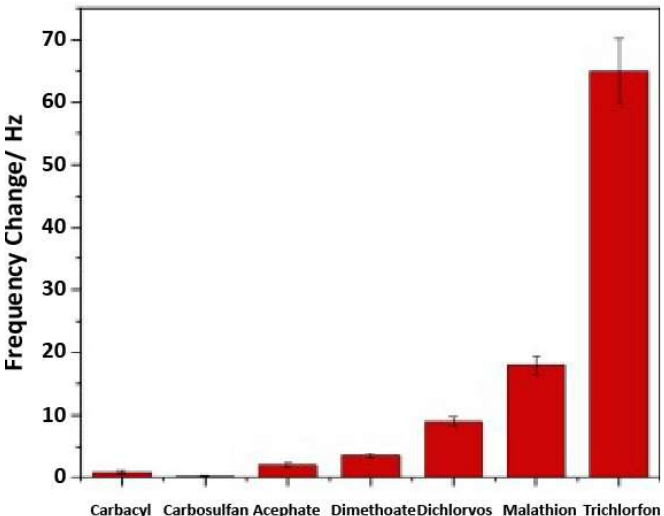
Figure 15. Selectivity of trichlorfon imprinted polymer at 100 ppb with various analogous com- pounds. MIPs were produced by combining 12 mg of polyvinylidene fluoride with 4 mg of template trichlorfon in 8 mL of dimethylformamide and drop-casting onto a quartz crystal. Reproduced with permission [111].